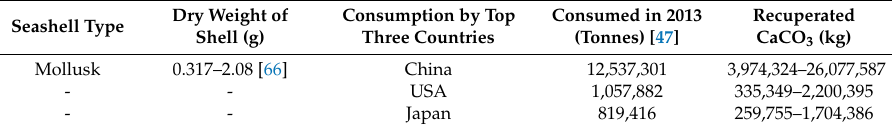
Table 4. Annual mollusk consumption by the top three countries in